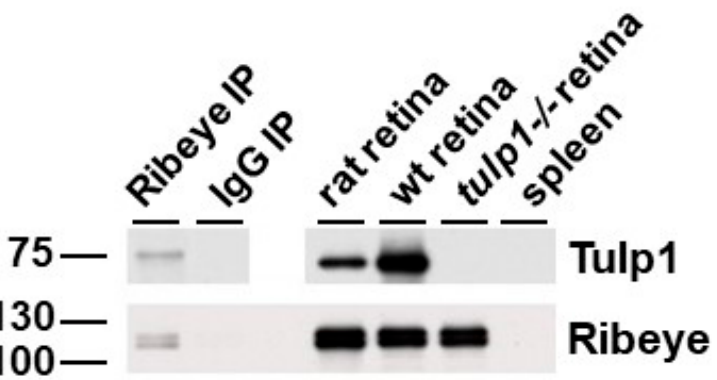
Figure 6. IP of retinal lysate. The top panels show Western blot analysis of the Ribeye IP experi- mental samples probed with Tulp1 antibodies. In the IP product lane, a band corresponding to Tulp1 is detected. A corresponding band is seen in the rat retinal lysate and wt mouse retinal ho- mogenate but not in the tulp1 − / − retinal lysate, spleen lysate or non-specific IgG IP lanes. The bottom panel shows Western blot analysis of the Ribeye IP experimental samples probed with Ribeye anti- bodies. In the IP product, rat retinal lysate, wt mouse retinal lysate and tulp1 − / − retinal lysate lanes, a band corresponding to Ribeye is detected. No bands are seen in the spleen or non-specific IgG IP sample lanes.